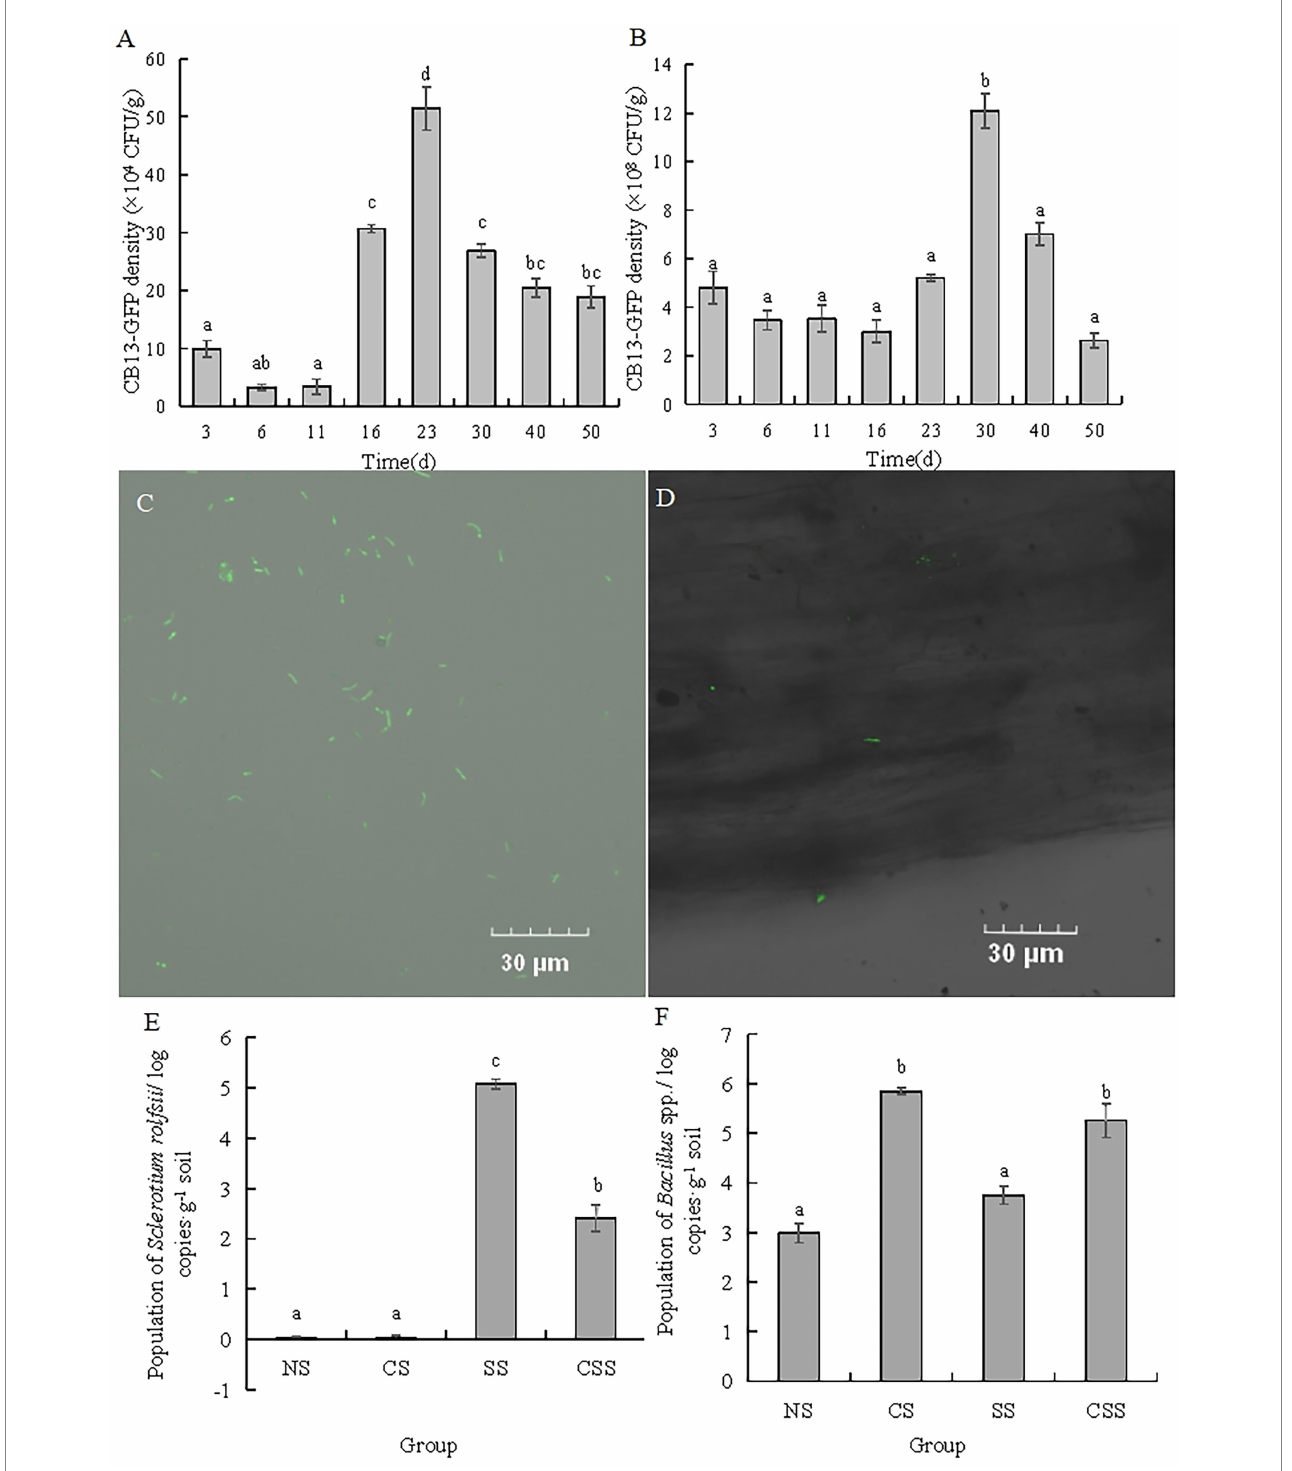
FIGURE 4 Analysis of colonization of Bacillus velezensis CB13 and Sclerotium rolfsii in peanut roots and rhizosphere soil. (A) The density of CB13-green fluorescent protein (GFP) in peanut root; (B) The density of CB13-GFP in peanut rhizosphere soil; (C) Fluorescence of bacterial cells emitted by strain CB13-GFP under the fluorescence microscope; (D) The colonization of CB13-GFP strain in root under the fluorescence microscope; (E) The quantification of Bacillus spp. in peanut rhizosphere soil by real-time quantitative PCR; (F) The quantification of S. rolfsii in peanut rhizosphere soil by qPCR; NS: uninoculated soil; CS: Soil inoculated with B. velezensis CB13; SS: Soil inoculated with S. rolfsii ; CSS: Soil inoculated with B. velezensis CB13 and S. rolfsii . Data are the means ± SE of three repeated experiments. Different letters above error bars indicate significant differences according to one-way ANOVA test ( p <